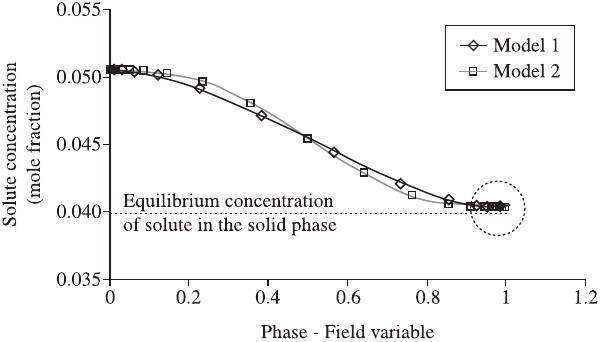
Figure 5. Maximum solute concentration of Ni-0.05 mole fraction of Cu as a function of solidification velocity: Model 1 means present work based on Kim et al. 6 ; Model 2 means present work base on Ramires et al. 7